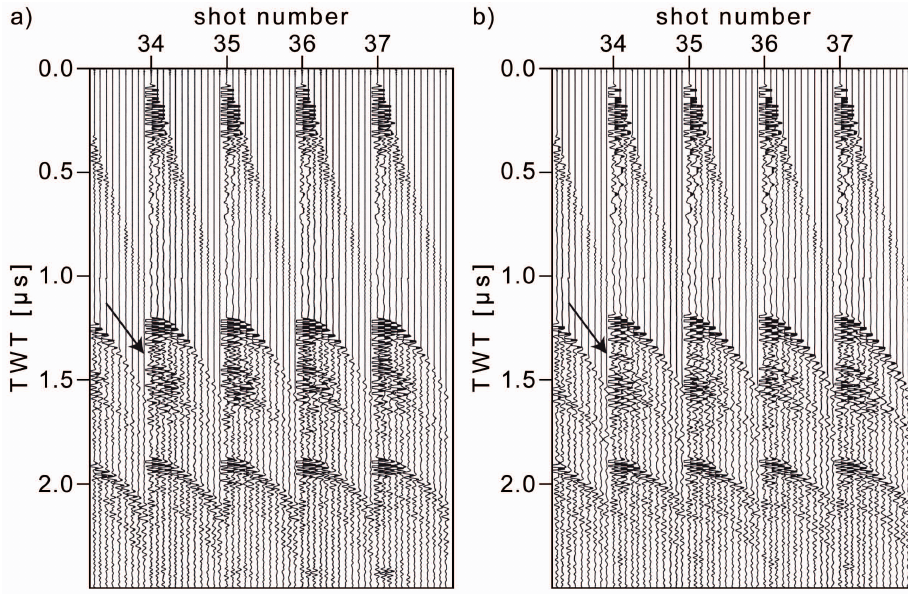
Fig. 8. Shot gathers of the channel model from the 450 kHz recording, (a) after spherical gain, and (b) after frequency stack followed by spherical gain. Here, the interface reflection at ca. 1.35µs is much better resolved (see arrows).